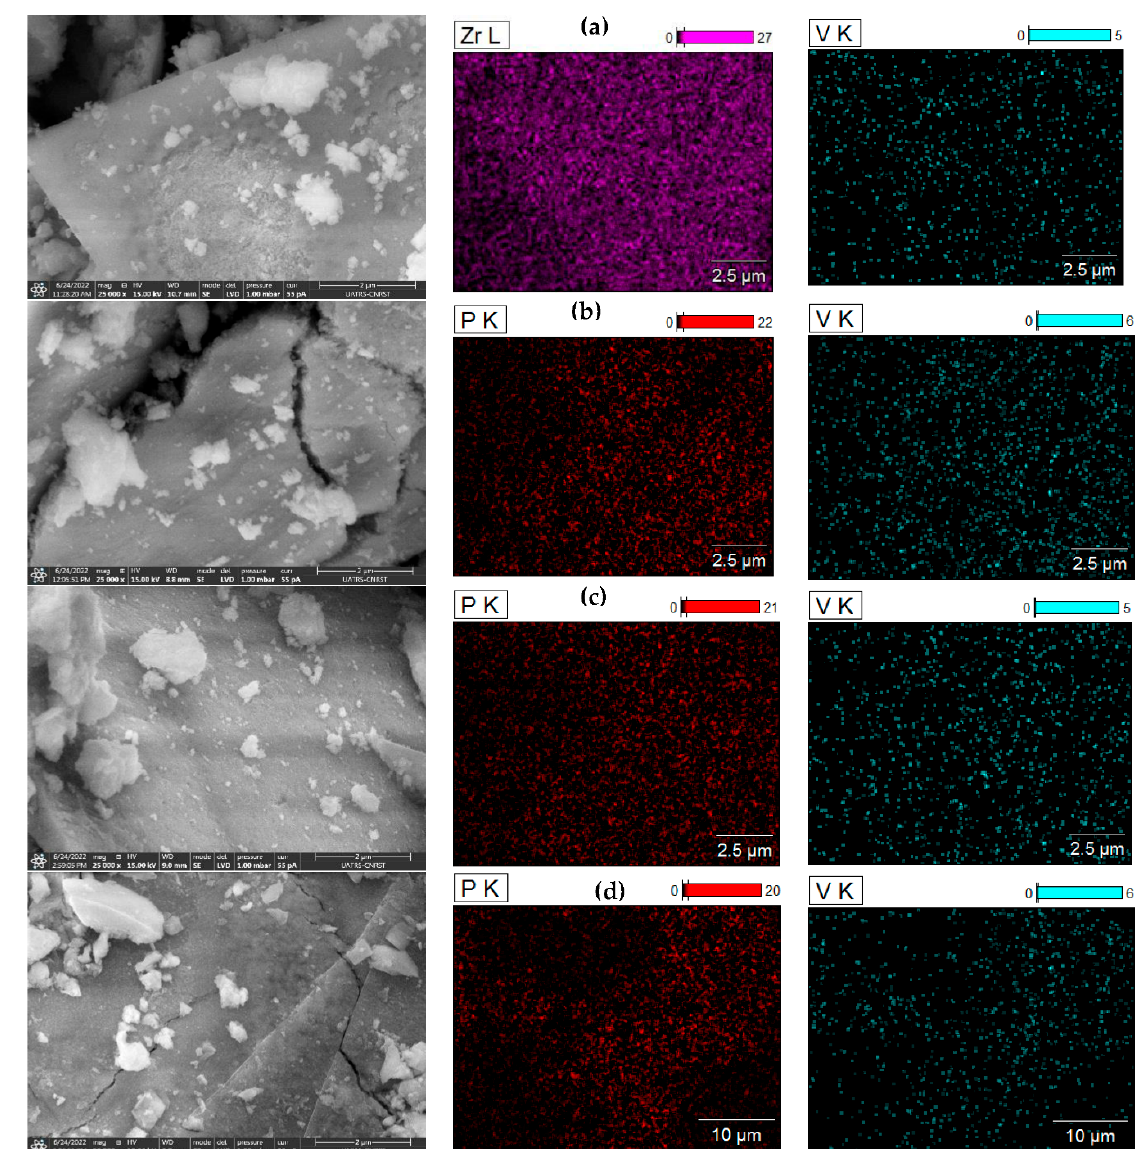
Figure 7. SEM and mapping images of the 3.6wt%V 2 O 5 /ZrO 2 loaded phosphate catalysts at different P/V ratio: ( a ) 3.6wt%V 2 O 5 /ZrO2; ( b ) P/V = 0.5; ( c ) P/V = 1; and ( d ) P/V = 2.